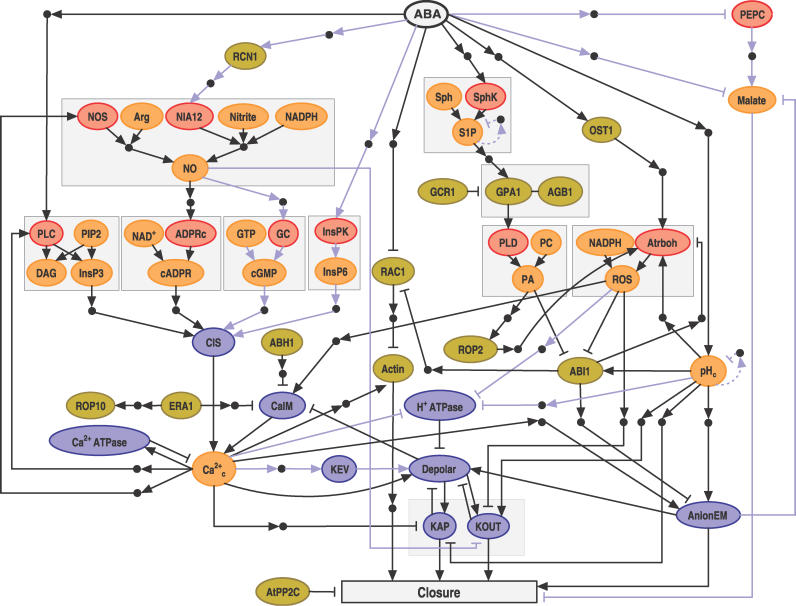
Current Knowledge of Guard Cell ABA SignalingThe color of the nodes represents their function: enzymes are shown in red, signal transduction proteins are green, membrane transport–related nodes are blue, and secondary messengers and small molecules are orange. Small black filled circles represent putative intermediary nodes mediating indirect regulatory interactions. Arrowheads represent activation, and short perpendicular bars indicate inhibition. Light blue lines denote interactions derived from species other than Arabidopsis; dashed light-blue lines denote inferred negative feedback loops on pHc and S1P. Nodes involved in the same metabolic pathway or protein complex are bordered by a gray box; only those arrows that point into or out of the box signify information flow (signal transduction).The full names of network components corresponding to each abbreviated node label are: ABA, abscisic acid; ABI1/2, protein phosphatase 2C ABI1/2; ABH1, mRNA cap binding protein; Actin, actin cytoskeleton reorganization; ADPRc, ADP ribose cyclase; AGB1, heterotrimeric G protein β component; AnionEM, anion efflux at the plasma membrane; Arg, arginine; AtPP2C, protein phosphatase 2C; Atrboh, NADPH oxidase; CaIM, Ca2+ influx across the plasma membrane; Ca2+ ATPase, Ca2+ ATPases and Ca2+/H+ antiporters responsible for Ca2+ efflux from the cytosol; Ca2+
c, cytosolic Ca2+ increase; cADPR, cyclic ADP-ribose; cGMP, cyclic GMP; CIS, Ca2+ influx to the cytosol from intracellular stores; DAG, diacylglycerol; Depolar, plasma membrane depolarization; ERA1, farnesyl transferase ERA1; GC, guanyl cyclase; GCR1, putative G protein–coupled receptor; GPA1, heterotrimeric G protein α subunit; GTP, guanosine 5′-triphosphate; H+ ATPase, H+ ATPase at the plasma membrane; InsPK, inositol polyphosphate kinase; InsP3, inositol-1,4,5-trisphosphate; InsP6, inositol hexakisphosphate; KAP, K+ efflux through rapidly activating K+ channels (AP channels) at the plasma membrane; KEV, K+ efflux from the vacuole to the cytosol; KOUT, K+ efflux through slowly activating outwardly-rectifying K+ channels at the plasma membrane; NAD+, nicotinamide adenine dinucleotide; NADPH, nicotinamide adenine dinucleotide phosphate; NOS, Nitric oxide synthase; NIA12, Nitrate reductase; NO, Nitric oxide; OST1, protein kinase open stomata 1; PA, phosphatidic acid; PC, phosphatidyl choline; PEPC, phosphoenolpyruvate carboxylase; PIP2, phosphatidylinositol 4,5-bisphosphate; PLC, phospholipase C; PLD, phospholipase D; RAC1, small GTPase RAC1; RCN1, protein phosphatase 2A; ROP2, small GTPase ROP2; ROP10, small GTPase ROP10; ROS, reactive oxygen species; SphK, sphingosine kinase; S1P, sphingosine-1-phosphate.